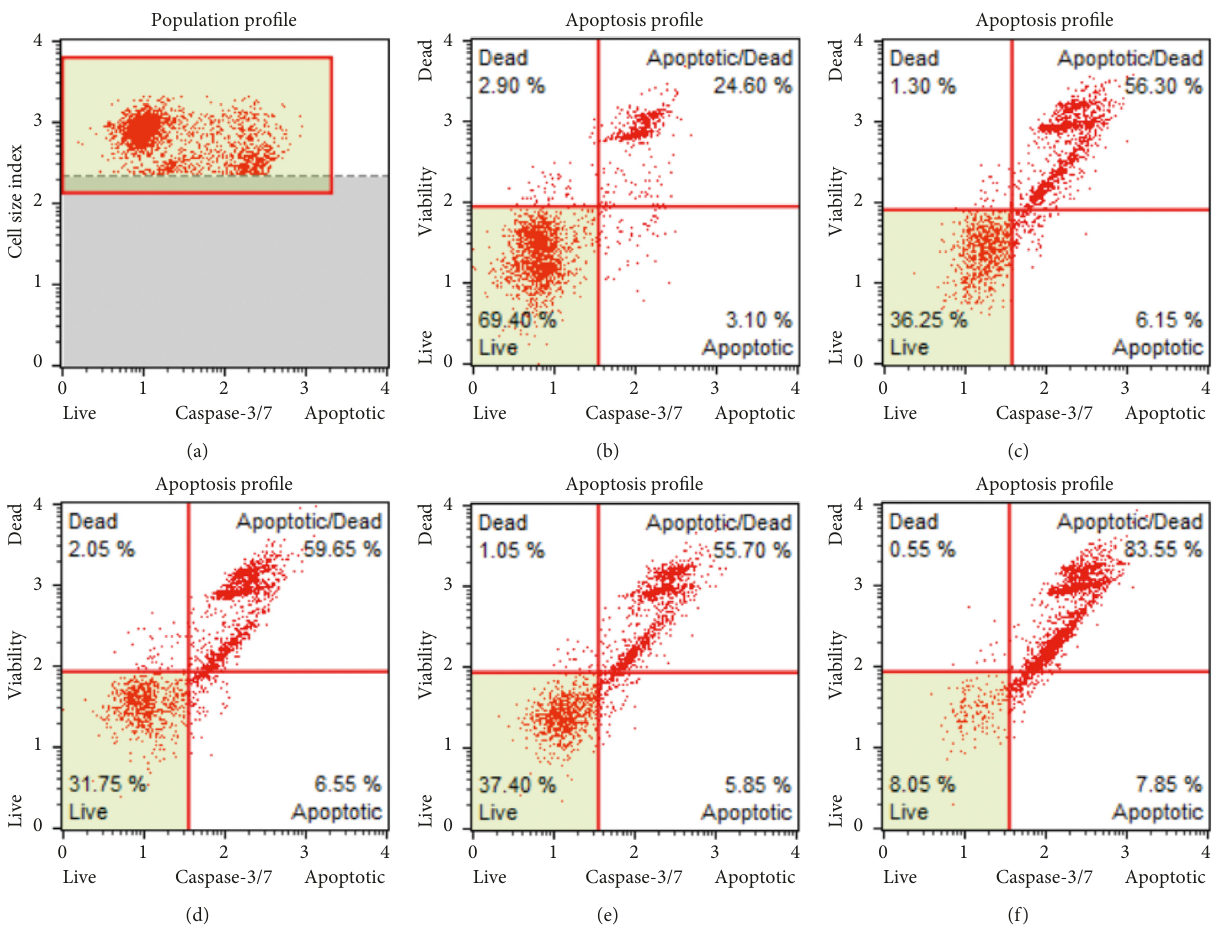
Figure 4: Apoptosis induction through the activation of caspase 3/7 after treatment with various compounds in HCT116cells was de- termined as % live, % early, and late apoptosis and % dead cells by the MUSE cell analyzer. (a) Normal control; (b) normal control; (c) SAHA (5 μ M); (d) quercetin (100 μ M); (e) QMJ-2 (100 μ M); (f) QMJ-5 (50 μ